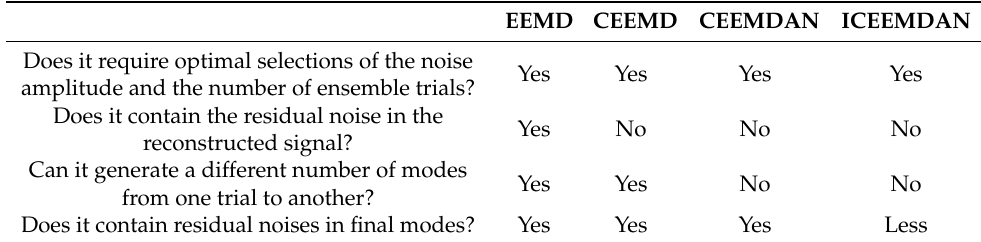
Table 1. Properties of the four noise-assisted EMD